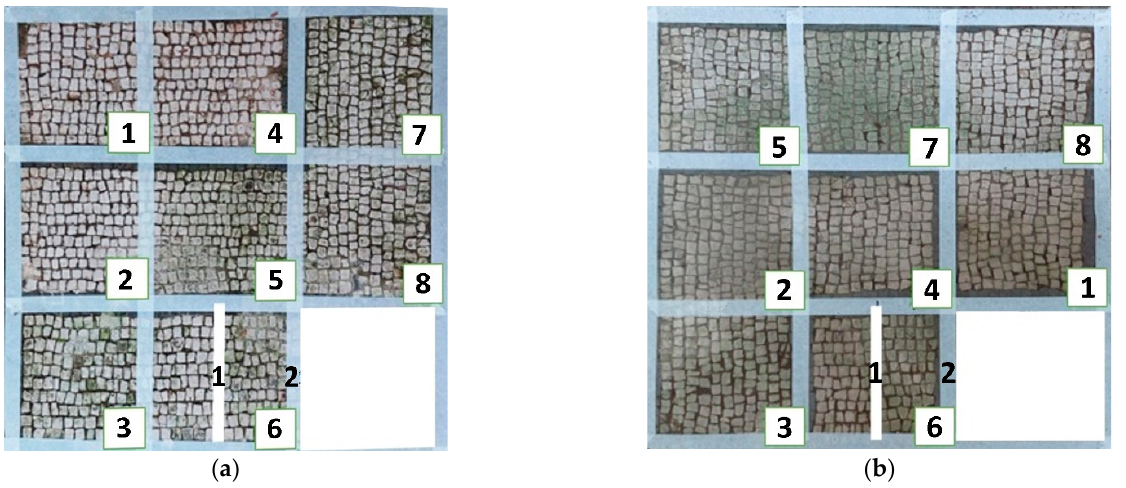
Figure 6. Images of Area 1 ( a ) and Area 2 ( b ) after seven months from the cleaning treatment. The chromatic parameter ∆ E* of Area 1 and Area 2 after seven months from the cleaning procedure are reported in Figure 7. Z8 of Area 1 (Biotersus) showed the best long- lasting effect. Partial effectiveness was reported in the areas treated using Essenzio (z3), SI-QUAT (z4), and Preventol ® RI50 (z2), followed by LIQ (z7), AUTEAB (z6_1), Bionature (z5), and washed AUTEAB (z6_2). As to the ∆ E* measured on the non-treated zone, the best action was reached by the product Preventol ® RI50 (z2), SI-QUAT (z4), and Bionature (z5). Slighter efficacy was observed in descending order on z6_1, z8, z3, z6_2, and z7, namely the areas treated with supported AUTEAB, Biotersus, Essenzio, washed AUTEAB,